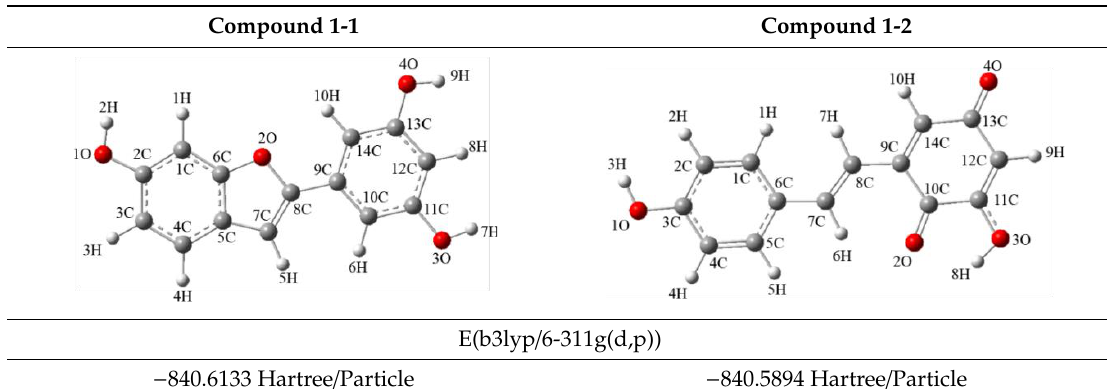
Table 2. The E(b3lyp / 6-311g(d,p)) of compound 1-1, 1-2 and parameters of the optimal configurations.